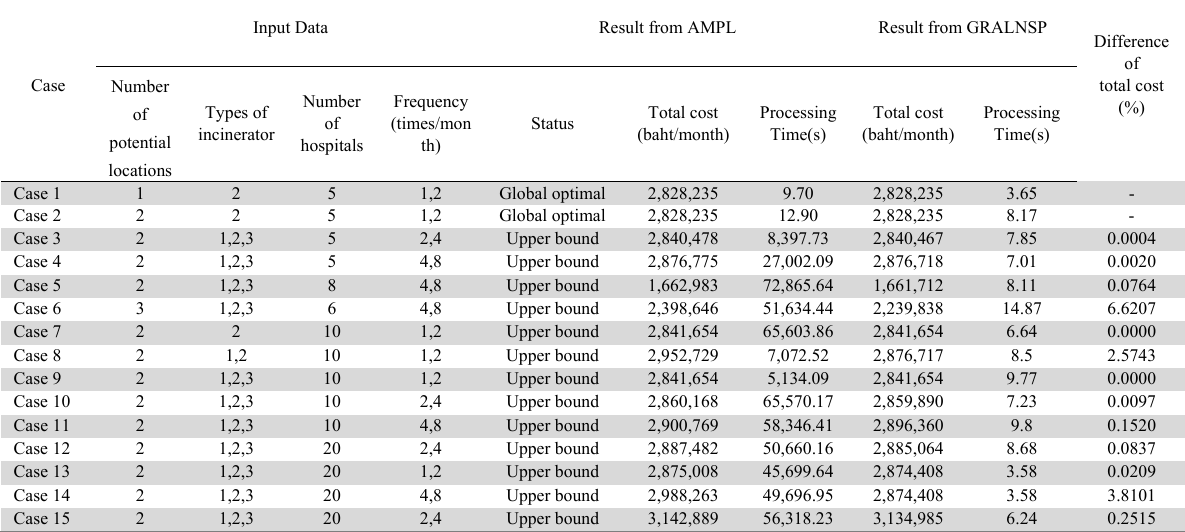
The result comparison of A Mathematical Programming Language (AMPL) and the